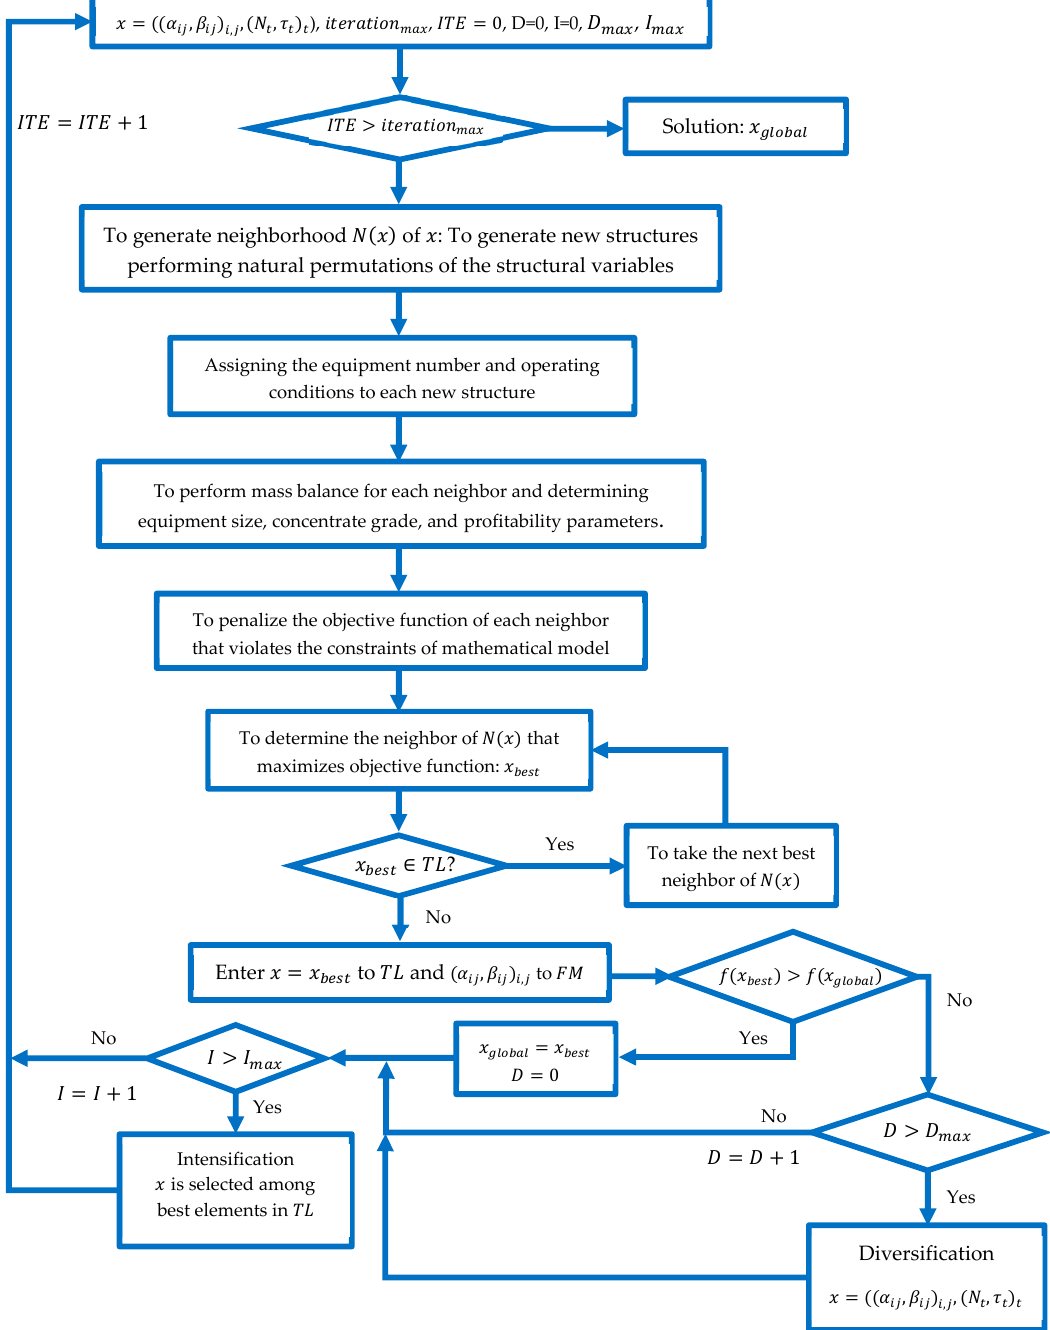
Figure 2. Block diagram of Tabu-search algorithm. ITE : iteration of algorithm, TL : Tabu list, FM : frequency matrix, D : iteration related to diversification, I : iteration related to intensification, (cid:16) (cid:17) α ij , β ij : circuit structure, ( N t , τ t ) : number of equipment and operating conditions of circuit, N ( x ) : t i , j neighborhood of the solution x , x best : best neighbor of N ( x ) , f : objective function, D max : number of iteration related to the implementation of diversification, I max : number of iteration related to the implementation of